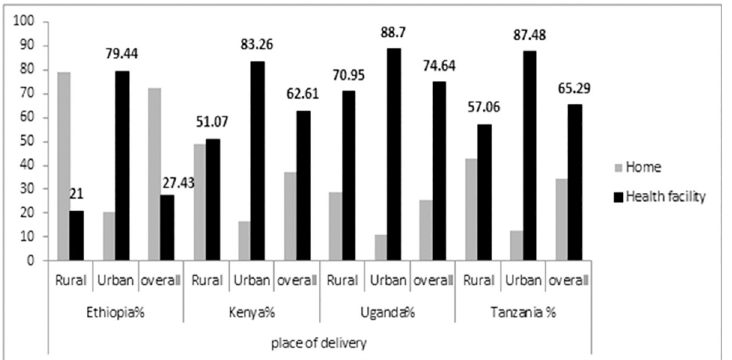
Fig 1. Proportion of institutional delivery in Ethiopia, Kenya, Uganda and Tanzania stratified by their residency.